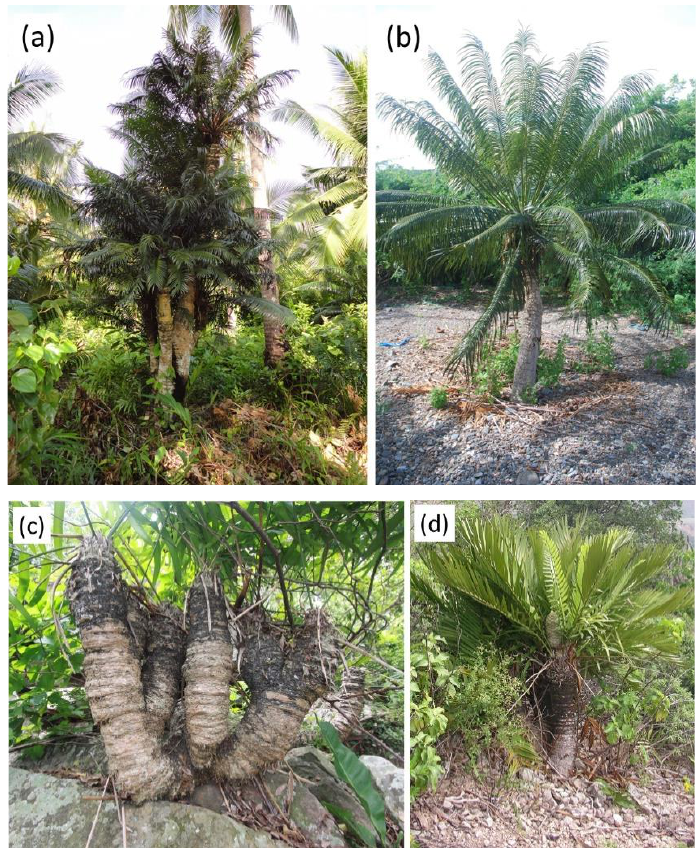
Figure 1. The appearance of Cycas plants in Guam and Philippines: ( a ) male; ( b ) female. The appearance of Zamia plants in Colombia: ( c ) male; ( d ) female.